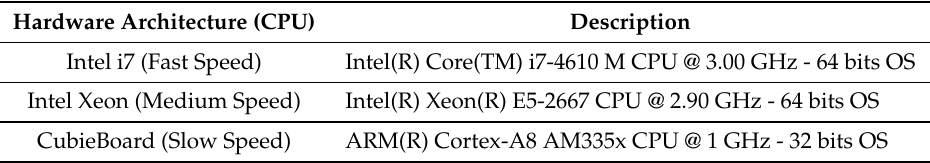
Table 3. Benchmarked hardware architectures.